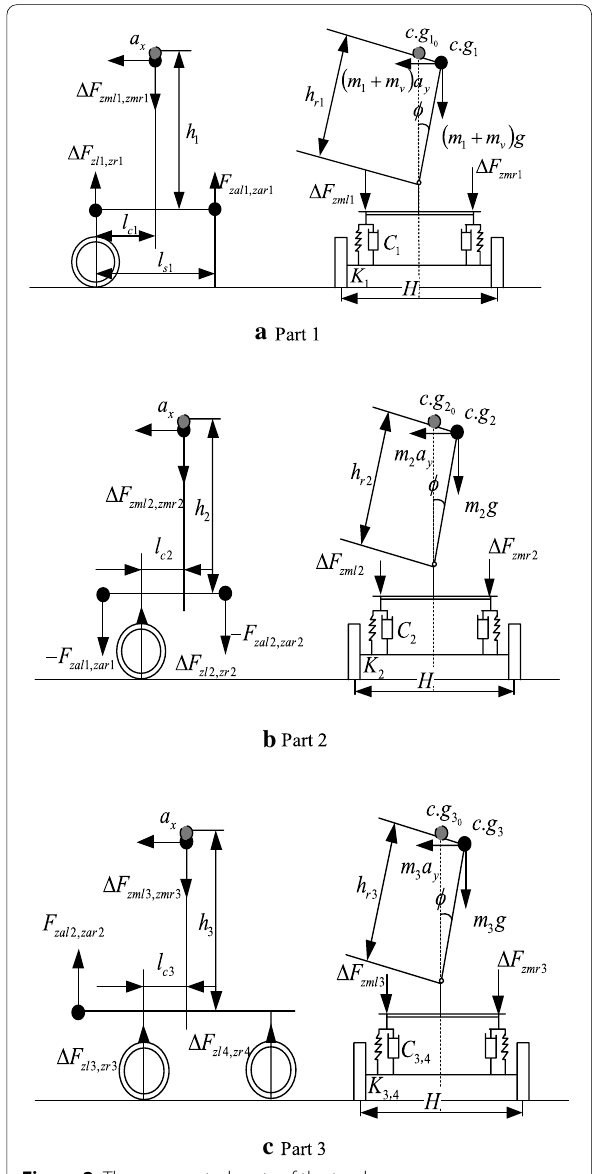
Figure 2 Three separated parts of the